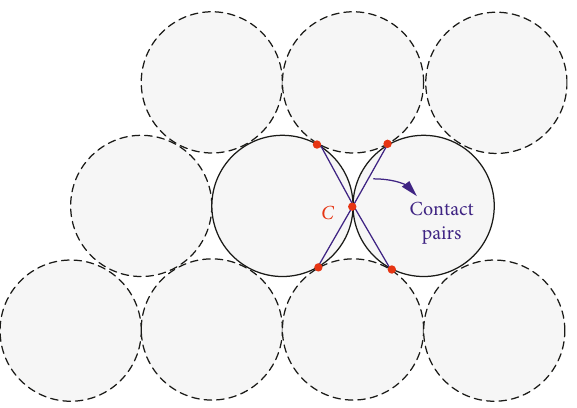
Figure 4: Contact pairs associated with the average of the equivalent strain of the contact C .